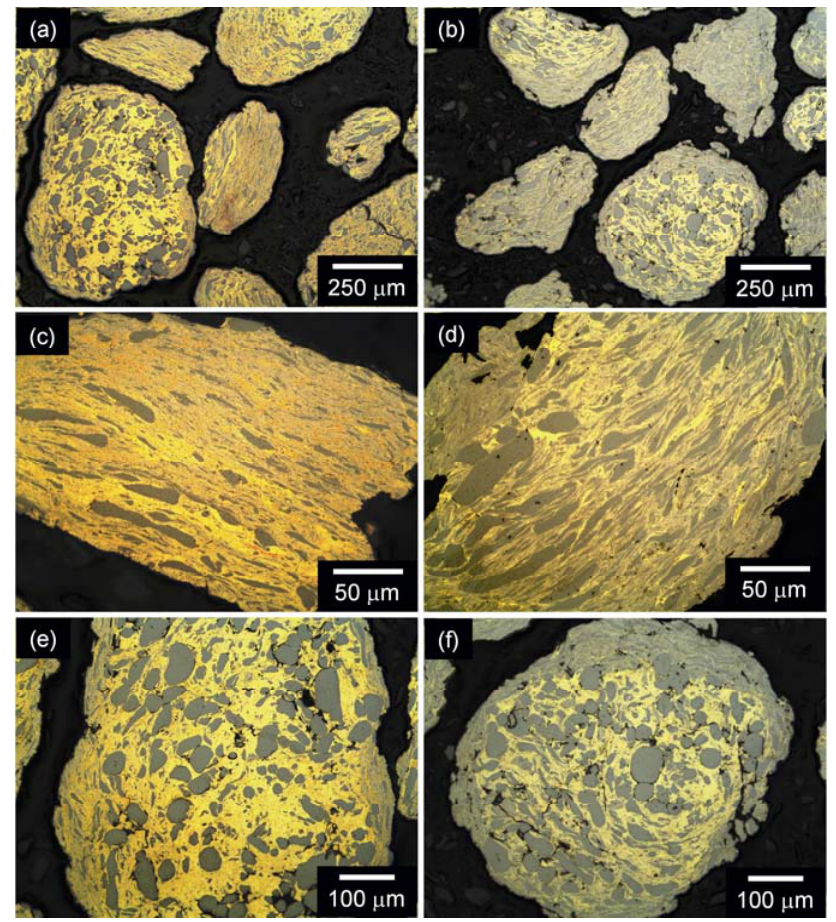
Figure 8. OM micrographs of the glass-brass composite powders milled for 20 h: glass